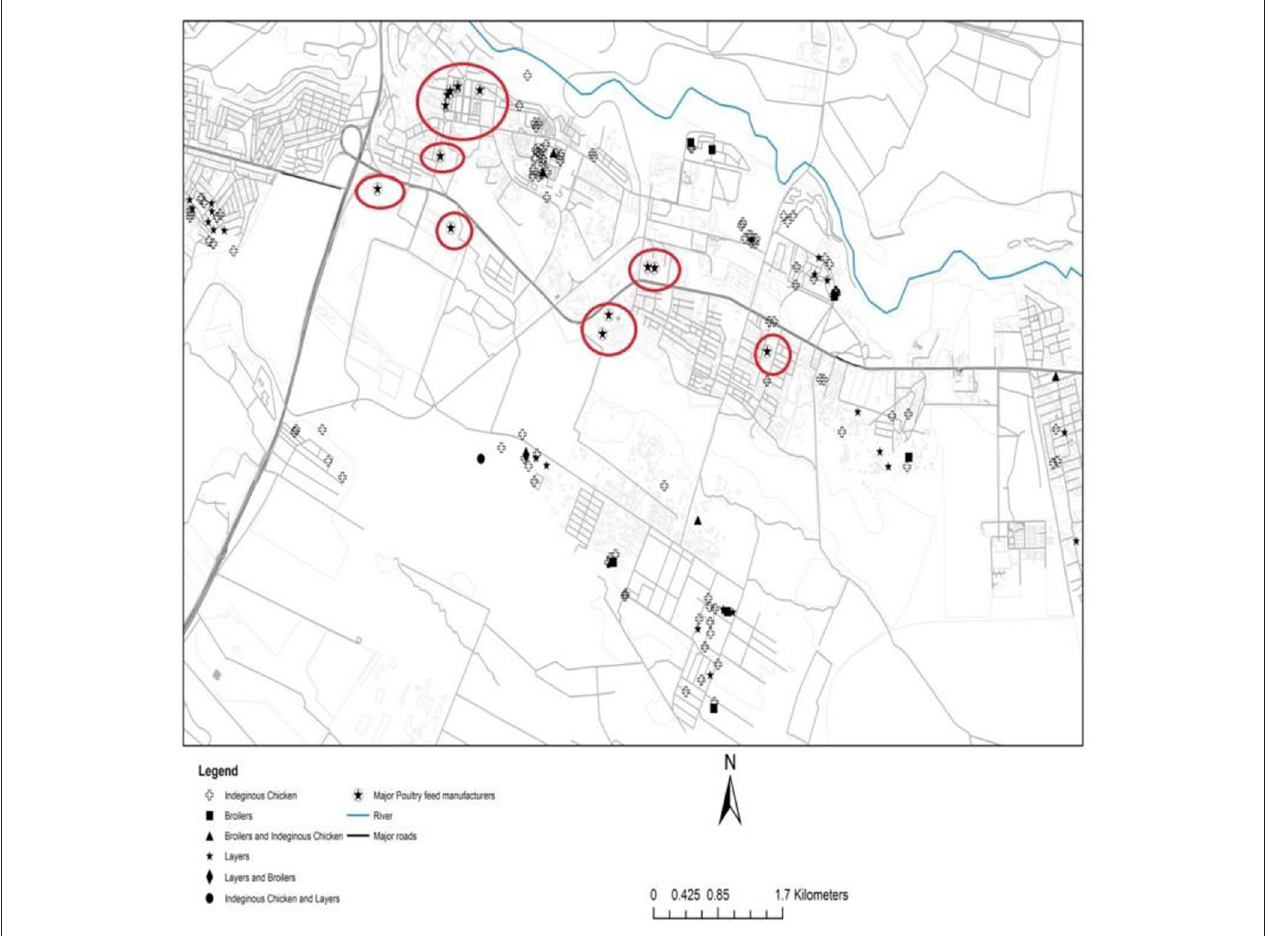
FIGURE 2 | Map of Thika showing location of poultry producers and input markets,